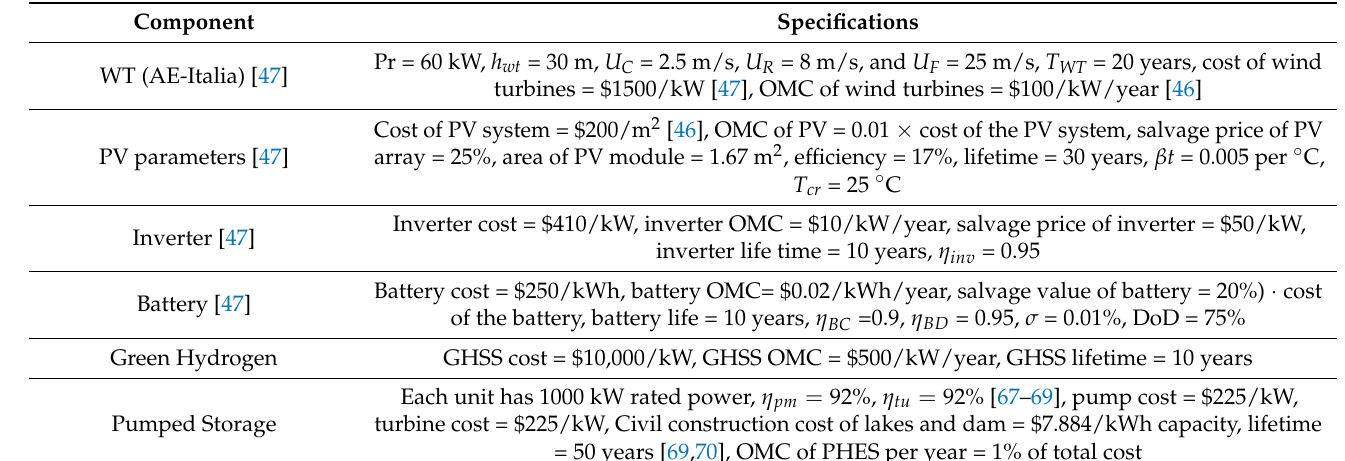
Table 2. The specifications of different HRES